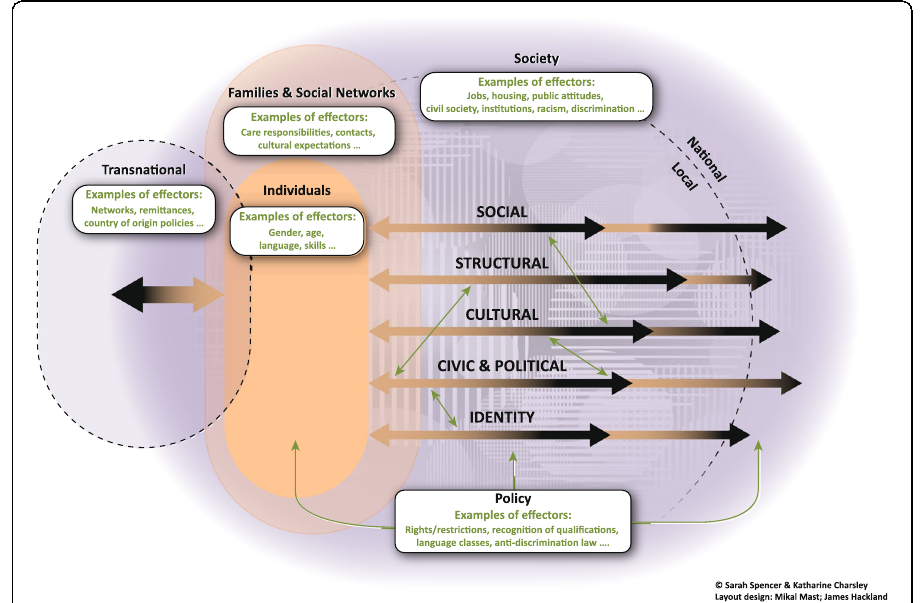
Fig. 5 Heuristic model of integration processes and effectors. Source: Spencer and Charsley 2016